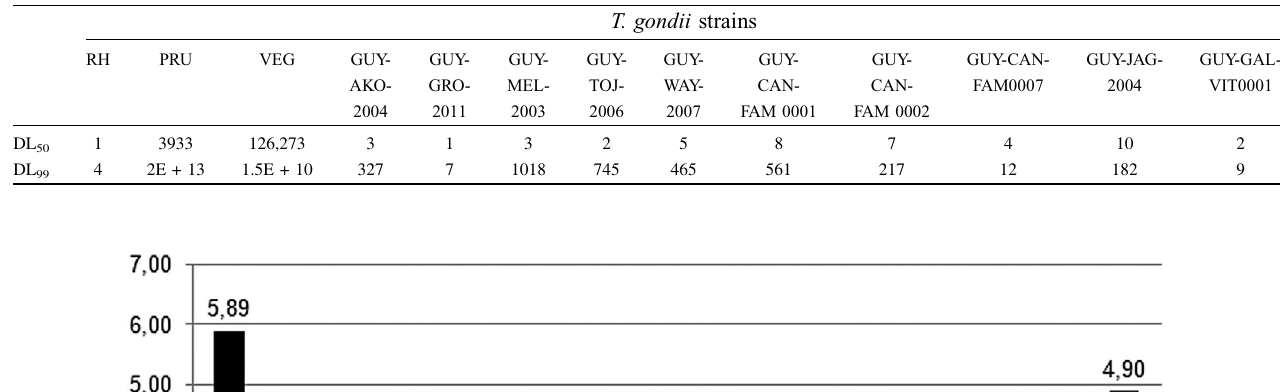
Table 3. Determination of LD 50 and LD 99